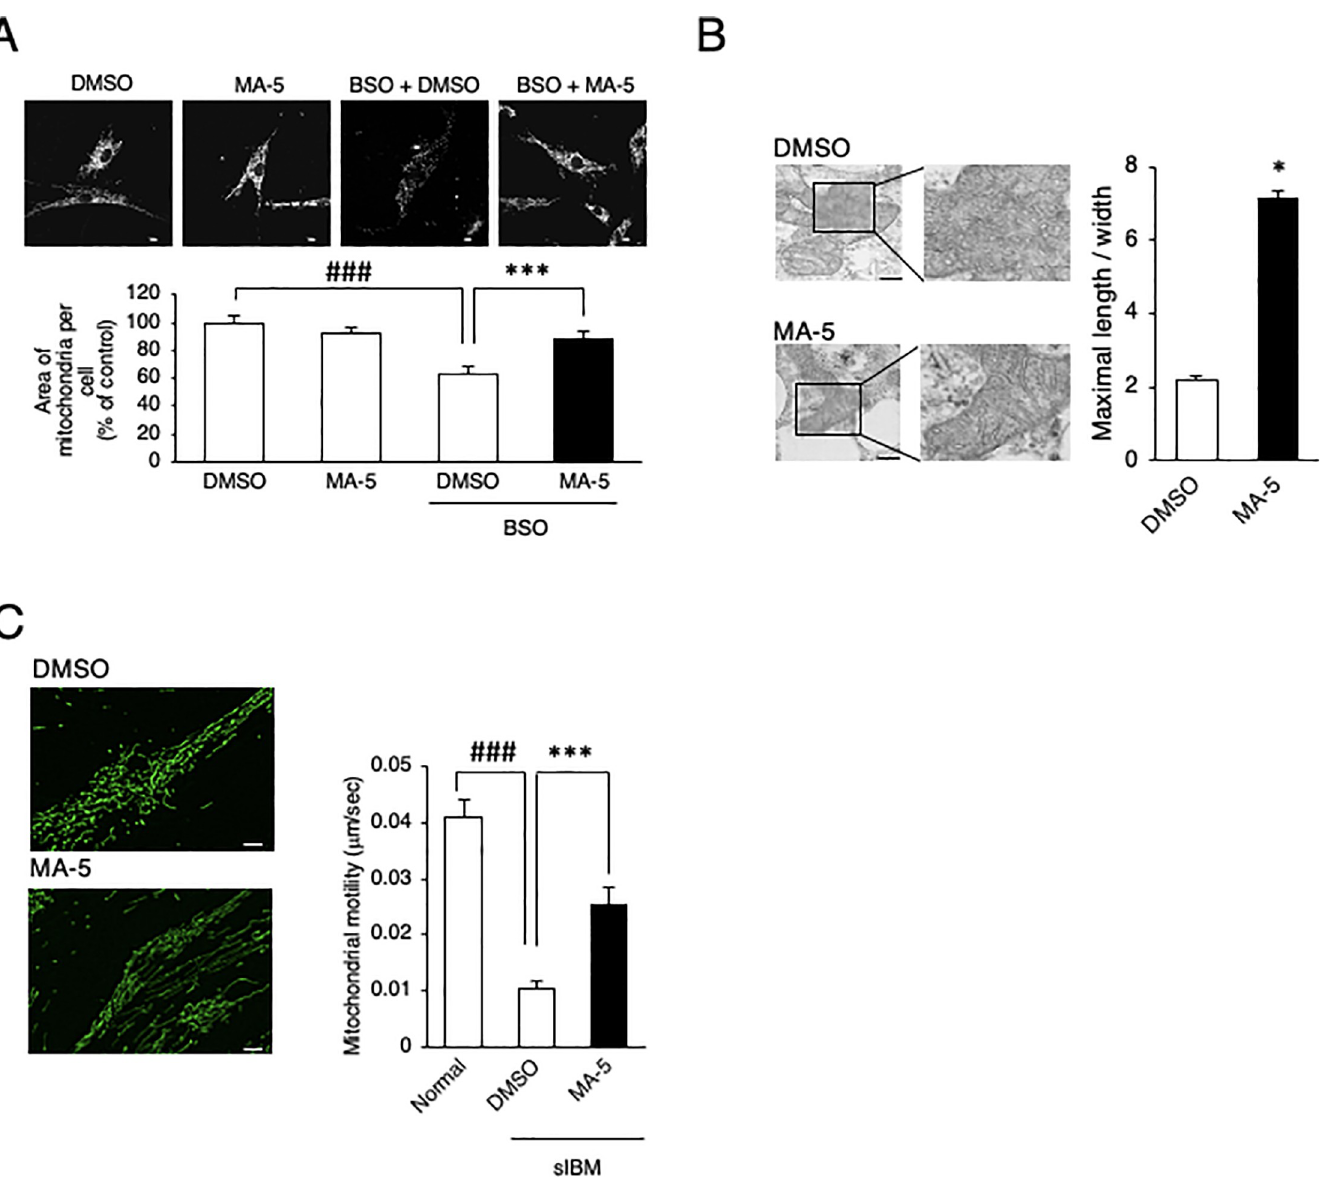
Fig 6. Effect of MA-5 on mitochondrial dynamics in sIBM skin fibroblasts. A. MA-5 improved mitochondrial fragmentation. Structural changes in mitochondria were observed in DMSO, MA-5, BSO + DMSO, BSO + MA-5 fibroblasts (300 μ M BSO, 0.1% DMSO and 10 μ M MA-5) using confocal microscopy imaging. The data represent the mean ± SE. ### p < 0.001 (unpaired two-tailed Student’s t -test versus DMSO); ��� p < 0.001 (unpaired two-tailed Student’s t -test versus BSO + DMSO). Scale bars = 10 μ m. B. MA-5 improved cristae length. Note that the cristae were damaged and that MA-5 lengthened and tightened the cristae. The ratio of cristae length to width was calculated (n = 100). The data represent the mean ± SE. � p < 0.05 (two-way ANOVA test versus DMSO). Scale bars = 200 nm . C. MA-5 improved mitochondrial motility. Mitochondrial motility in sIBM myoblasts treated with DMSO (upper) or with MA-5 (lower) was measured. Note that mitochondrial motility was significantly increased by MA-5. The data represent the mean ± SE. ### p < 0.001 (unpaired two-tailed Student’s t -test versus normal fibroblasts); ��� p < 0.001 (unpaired two-tailed Student’s t -test versus sIBM fibroblasts treated with